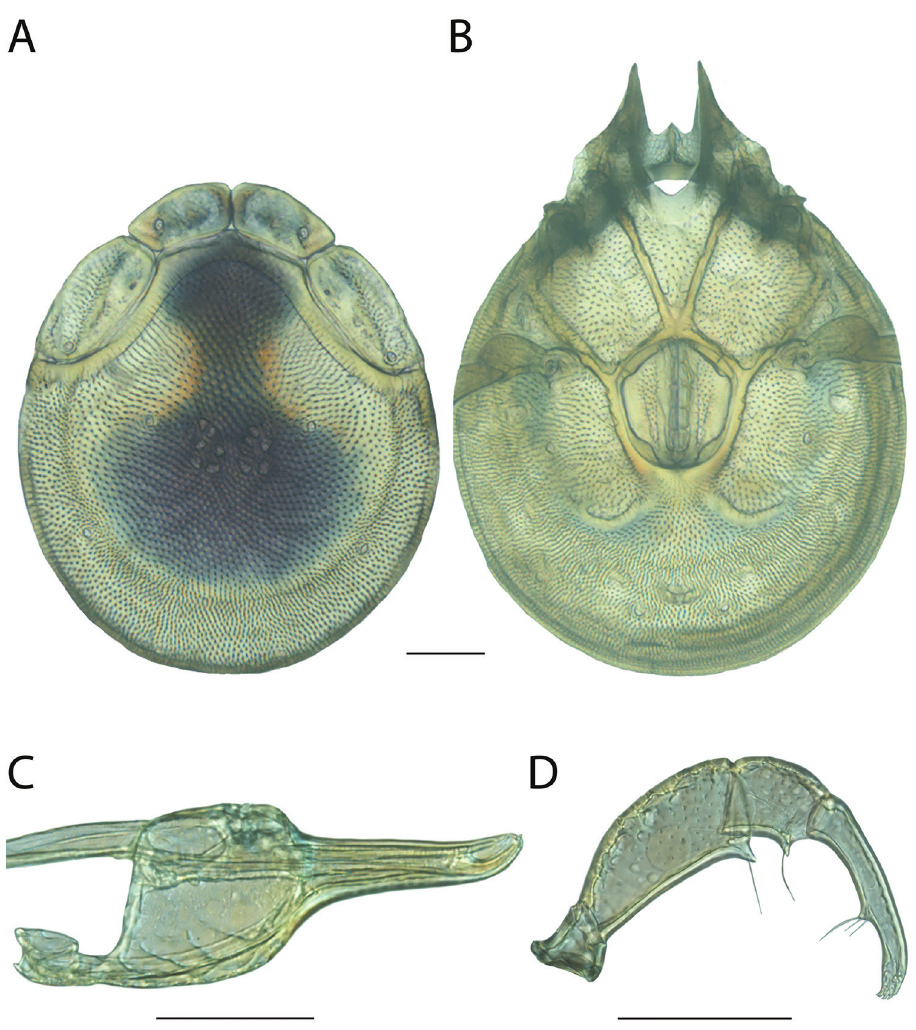
Figure 150. Torrenticola mjolniri sp. n. female: A dorsal plates B venter (legs removed) C subcapitulum D pedipalp (setae not accurately depicted). Scale = 100